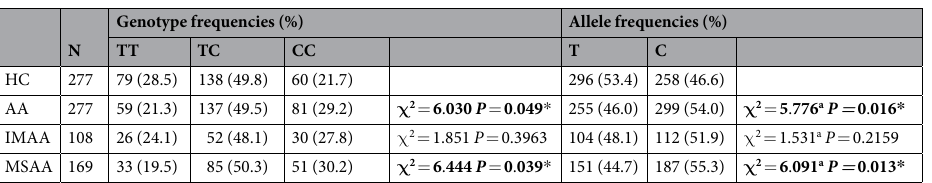
In the current study, we report data supporting an increase of NSE and monocytes and a down-modulation of their mCD14 expression in allergic asthma regardless of disease severity. In addition, we detect a decrease of